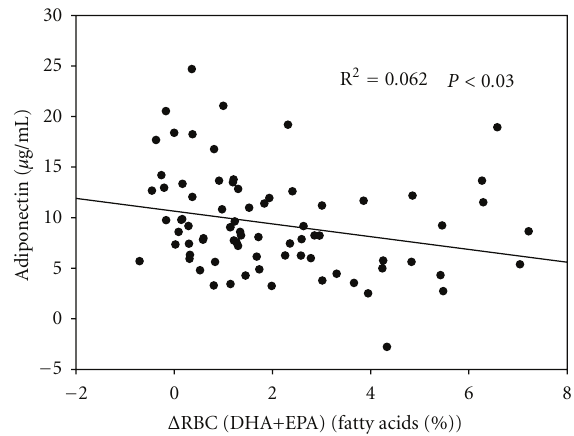
Figure 1: The correlation between the change in DHA+EPA con- tent of RBC and plasma adiponectin at the end of the intervention adjusted for baseline values and changes in fat